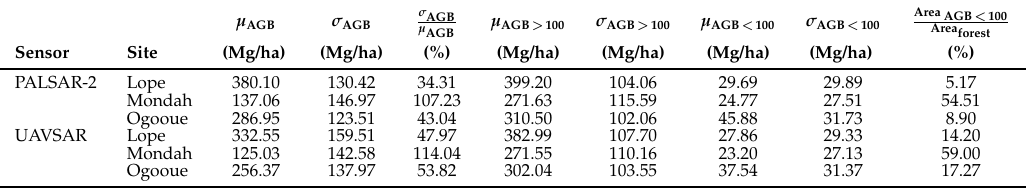
Table 1. Below, descriptive statistics of the LVIS-derived reference AGB in the study areas with respect to sensor coverage area. The µ AGB , µ AGB < 100 , and µ AGB > 100 are the mean AGB, the mean AGB for areas with AGB below 100 Mg/ha, and the mean AGB for areas with AGB above 100 Mg/ha, respectively. Similarly defined are σ AGB , σ AGB < 100 , and σ AGB > 100 for standard deviations over our study areas. The last column records the ratio of high AGB (above 100 Mg/ha) area to the total forest in the study